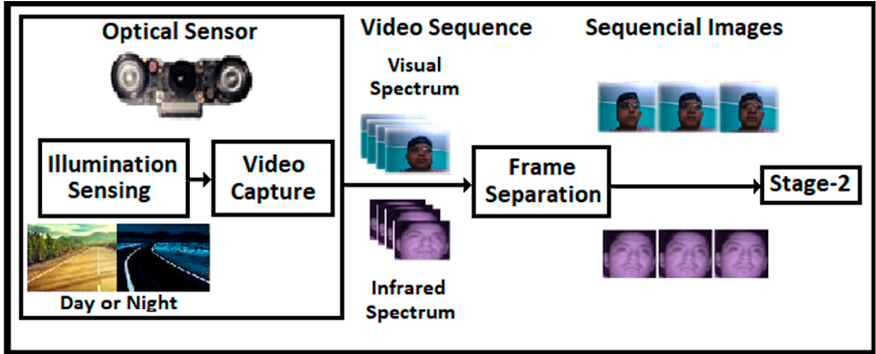
Figure 2. Process of obtaining images in different lighting conditions.